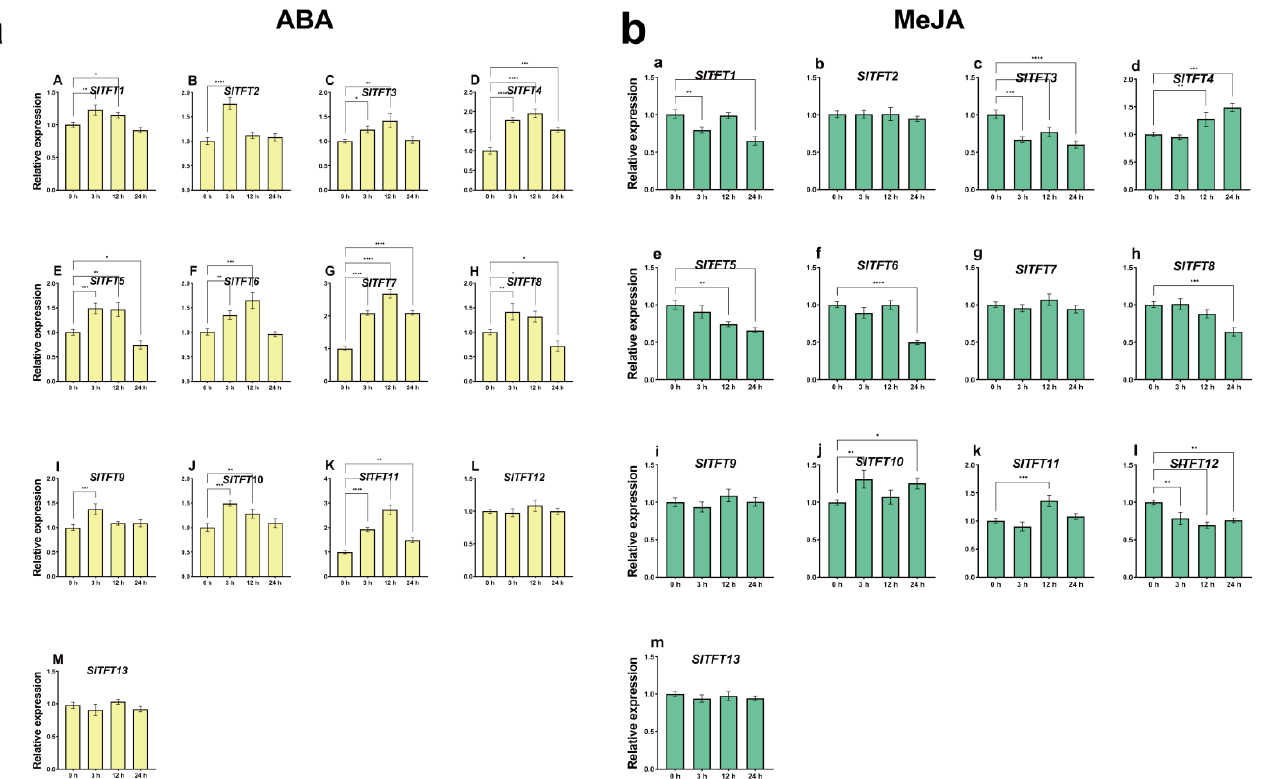
Figure 9. Responses of 13 SlTFTs to different phytohormone ABA ( a ) or MeJA ( b ) treatments. ( a ) A to M represent SlTFT1 to SlTFT13 , respectively. The horizontal coordinates in the figure are the four different treatment periods under 100 µ M ABA treatment, and the vertical coordinates are the relative expression of each SlTFT gene. ( b ) a to m represent SlTFT1 to SlTFT13 , respectively. The horizontal coordinates in the figure are the four different treatment periods under 100 µ M MeJA treatment, and the vertical coordinates are the relative expression of each SlTFT gene. Error bars are the standard SD of three independent biological replicates, presented as mean ± SD. The statistical significance of differences was confirmed by Dunnett’s multiple comparison test (* p < 0.05, ** p < 0.01, *** p < 0.001, and **** p < 0.0001).